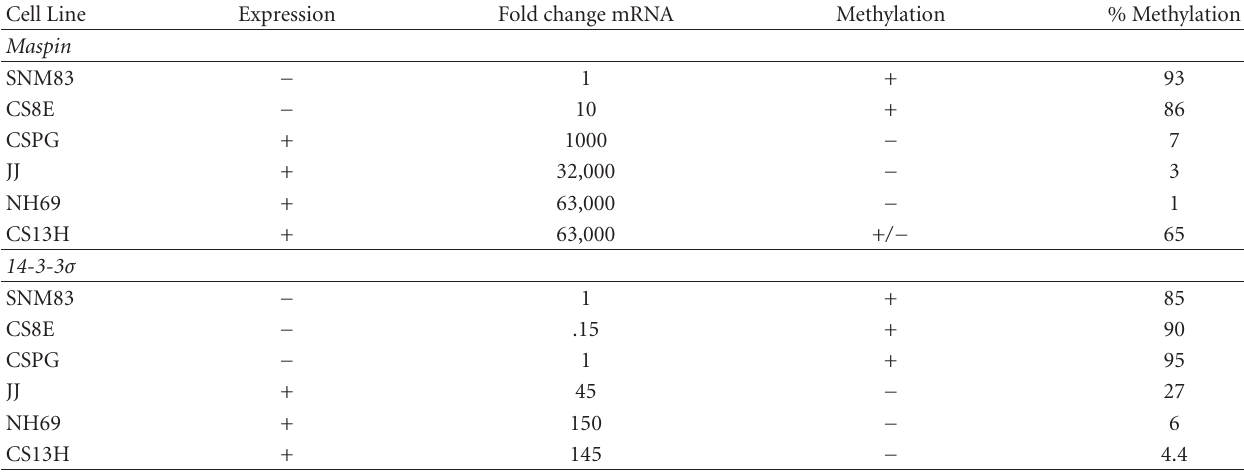
Table 1: Summary of maspin and 14-3-3 σ mRNA expression and cytosine methylation states in human chondrosarcoma cell lines. Cell